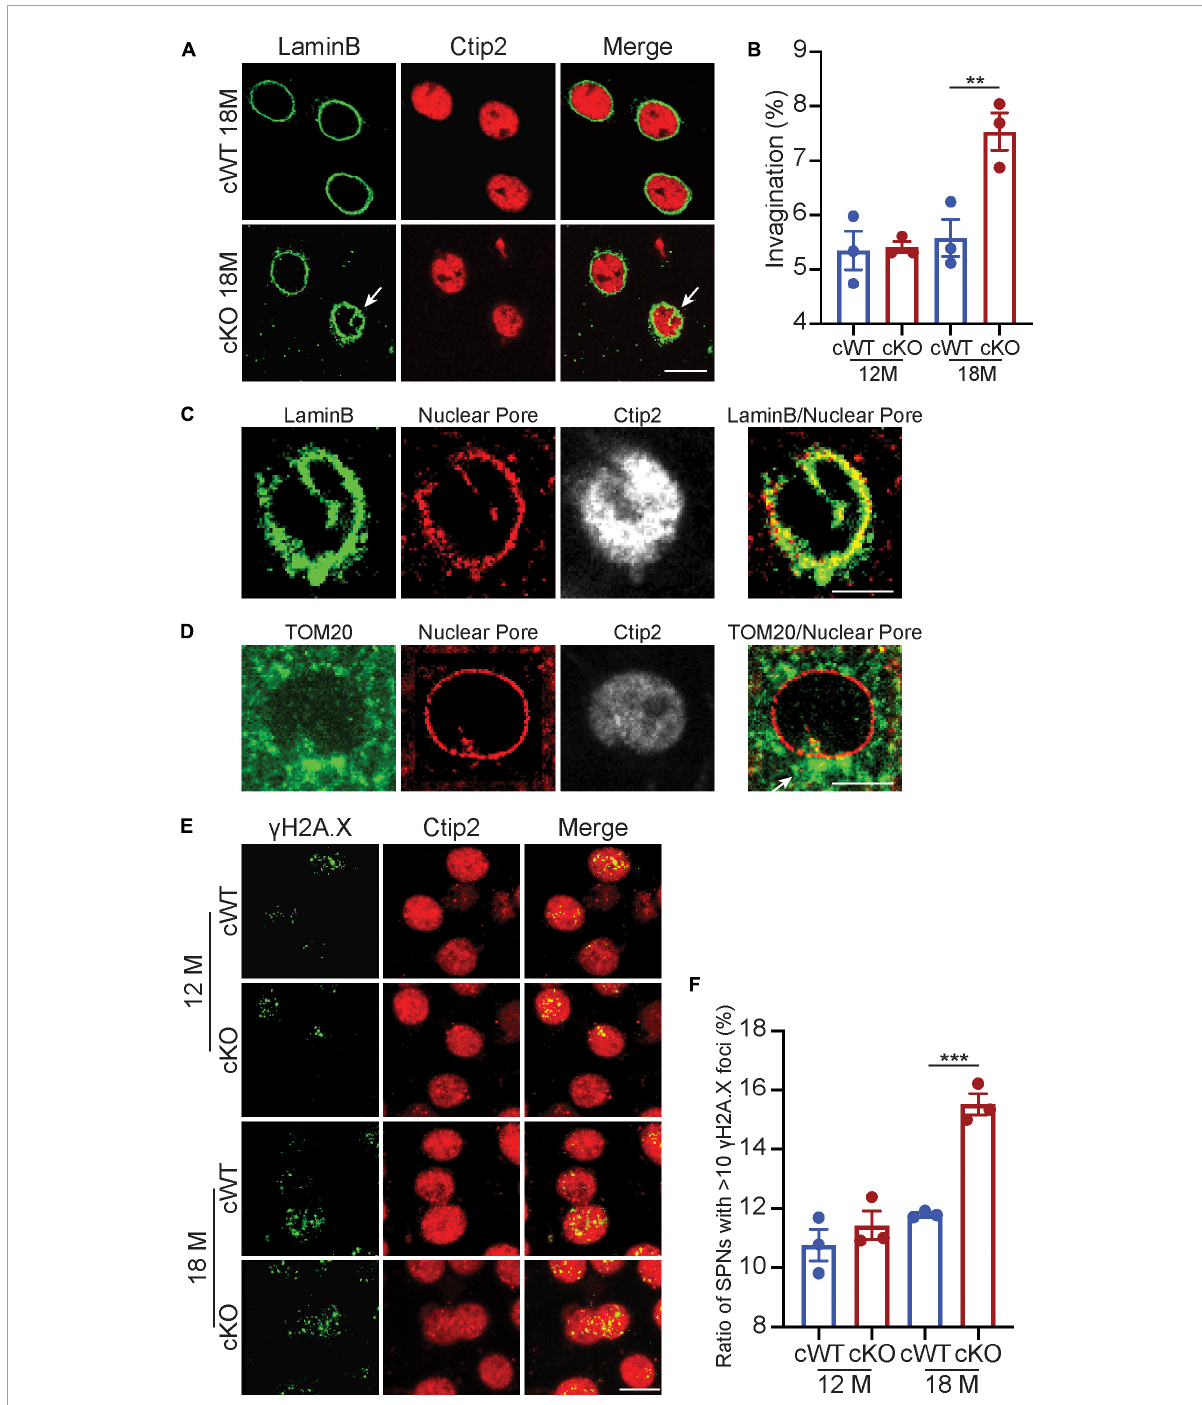
FIGURE4 Nuclear invaginations increase accompanied with genomic instability in Pitx3 cKO mice. (A) Co-staining of LaminB and Ctip2 in MSNs of 18-month-old Pitx3 cWT and Pitx3 cKO mice (scale bar: 10 µ m) white arrow points to nuclear invagination. (B) Ratio of MSN nuclei containing ≥ 1 invagination in Pitx3 cWT and Pitx3 cKO mice at 12 ( N = 3 mice per genotype; all males) and 18 ( N = 3 mice per genotype; all males) month of age. Unpaired t -test, ** p = 0.0041. (C) Co-staining of Nuclear Pore and LaminB (scale bar: 5 µ m). (D) Costaining of Nuclear Pore and TOM20 (scale bar: 5 µ m). White arrow points to a cluster of mitochondria. (E) Co- staining of γ H2A.X and Ctip2 in the striatal sections of 12- and 18-month-old Pitx3 cWT and Pitx3 cKO mice (scale bar: 10 µ m). (F) The ratios of MSNs with 10 or more γ H2A.X-positive foci in the nuclei ( N = 3 mice per genotype). Unpaired t -test, *** p =